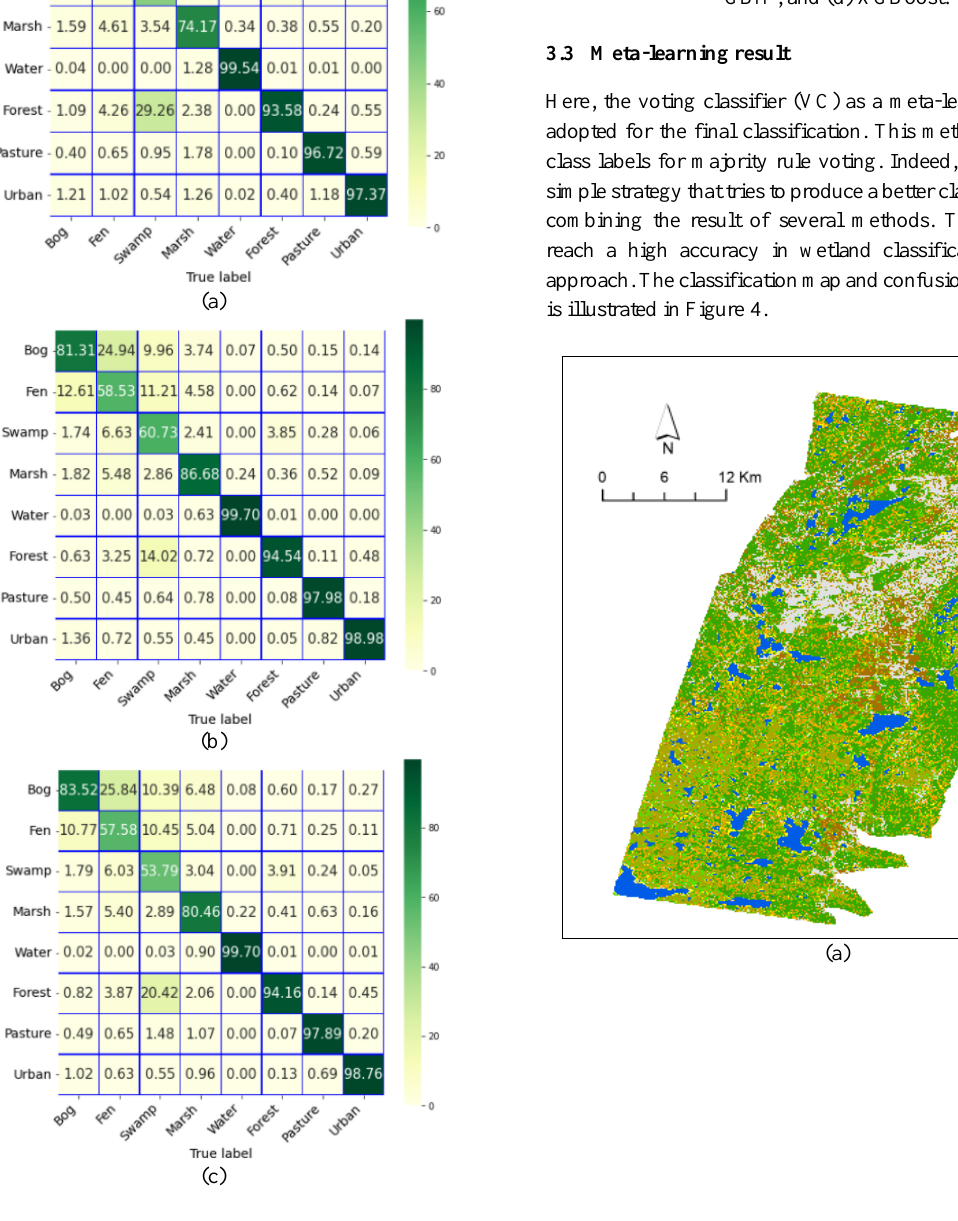
Figure 3 . The confusion matrices for: (a) DT, (b) RF, (c) GBM, and (d)